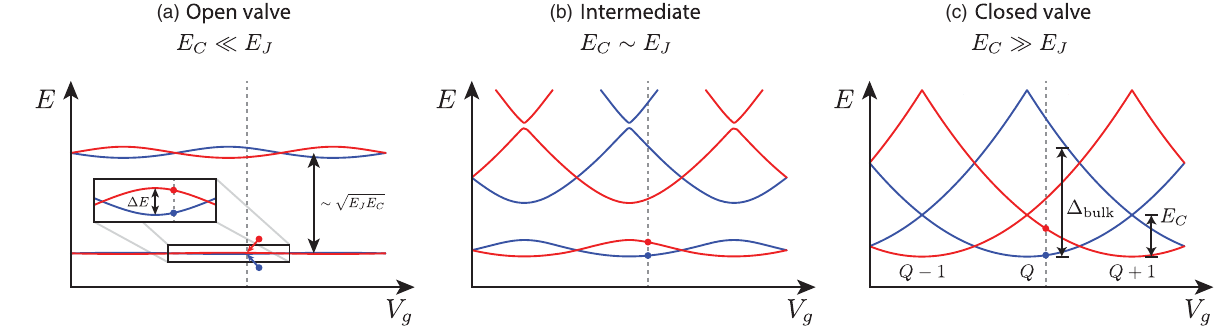
FIG. 2. Energy levels versus back gate voltage V for the single-island setup in Fig. 1 with the gate-tunable valve (a) fully open, g (b) partially transmitting, and (c) fully closed. Red and blue curves correspond to states with even and odd electron number. For the open configuration in (a), Josephson energy E dominates charging energy E . The island thus hosts a pair of Majorana zero modes that J C encode an approximate twofold topological ground-state degeneracy. Residual charging energy splits the degeneracy, but only by an =E amount Δ E exponentially small in E . Closing the valve effectively ramps up Coulomb effects, which dominate in the fully closed J C configuration of (c). There, the eigenstates are generally nondegenerate (except with fine-tuning) and carry well-defined island charges … Q − 1 ; Q; Q þ 1 … , as labeled on the right. Crucially, the topologically degenerate ground states smoothly evolve into nondegenerate charge eigenstates as the valve closes — signifying parity-to-charge conversion. The red and blue dots illustrate this phenomenon at one particular gate voltage indicated by the vertical dashed